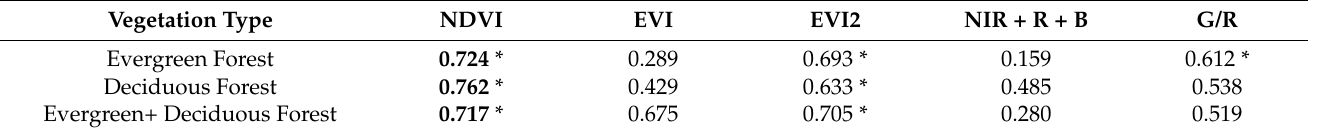
Table 3. The correlation coefficients between the interannual variations in each greenness characteris- tic and the outbreak dates of pollen